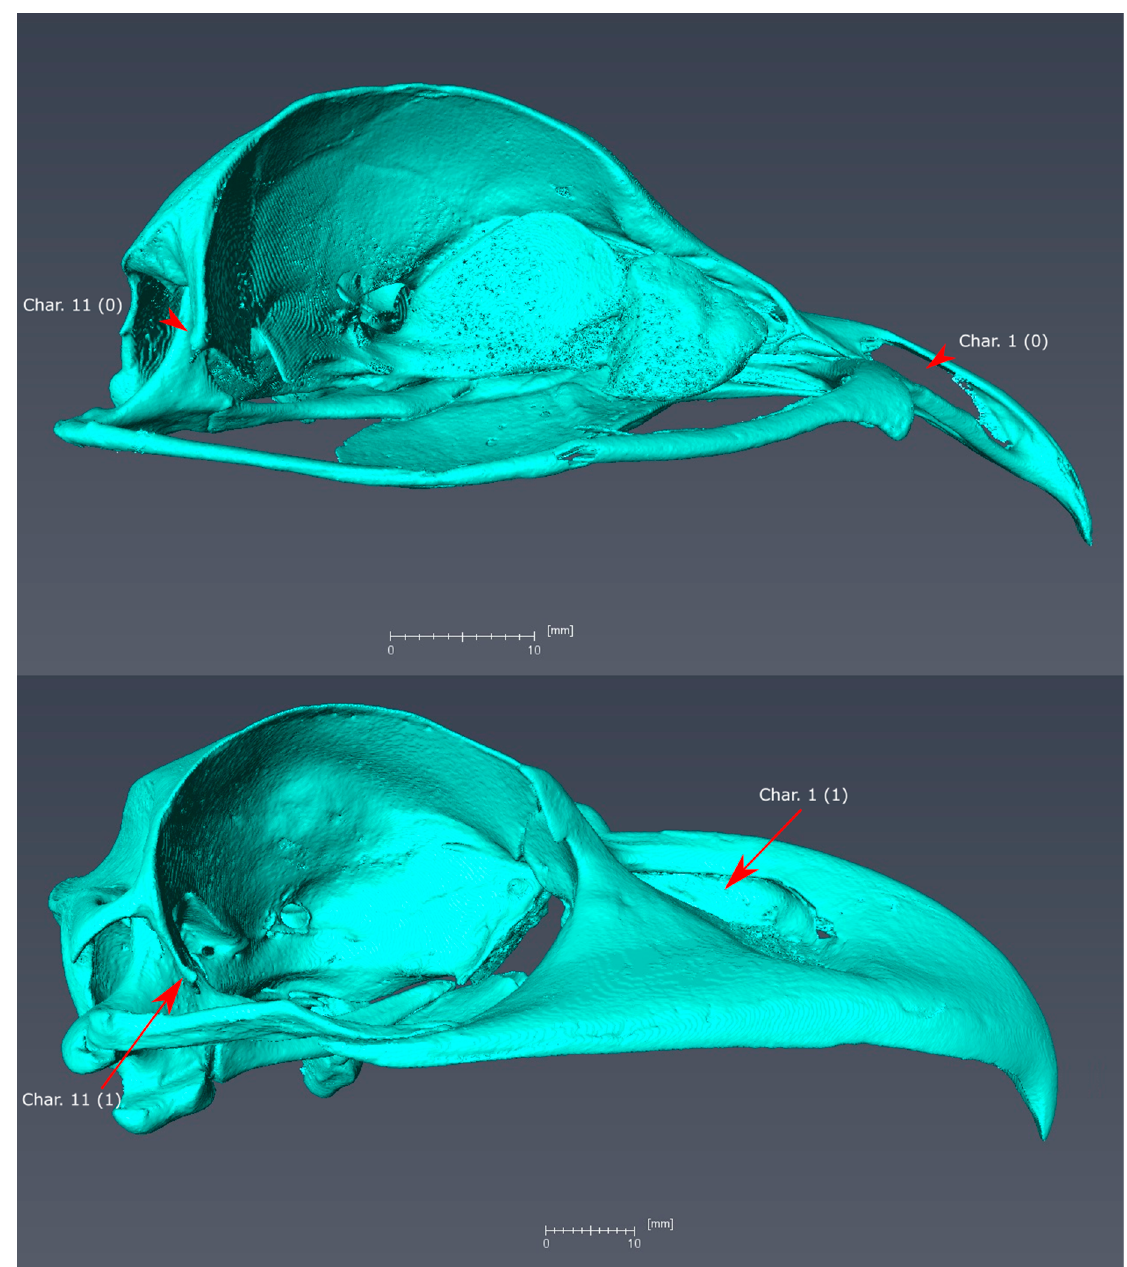
Figure A4. Crania of Nyctibius griseus (top) and Podargus strigoides (bottom) in lateral view. Nyctibius exhibits state 0 for character 1 (ossified nasal septum absent), whereas Podargus exhibits state 1 (ossified nasal septum present, optimized as a synapomorphy of Podargiformes). Nyctibius also exhibits state 0 for character 11 (postorbital process short and not approaching the jugal bar), whereas Podargus exhibits state 1 (postorbital process elongated such that it nearly touches the jugal bar, optimized as a synapomorphy of Podargiformes).